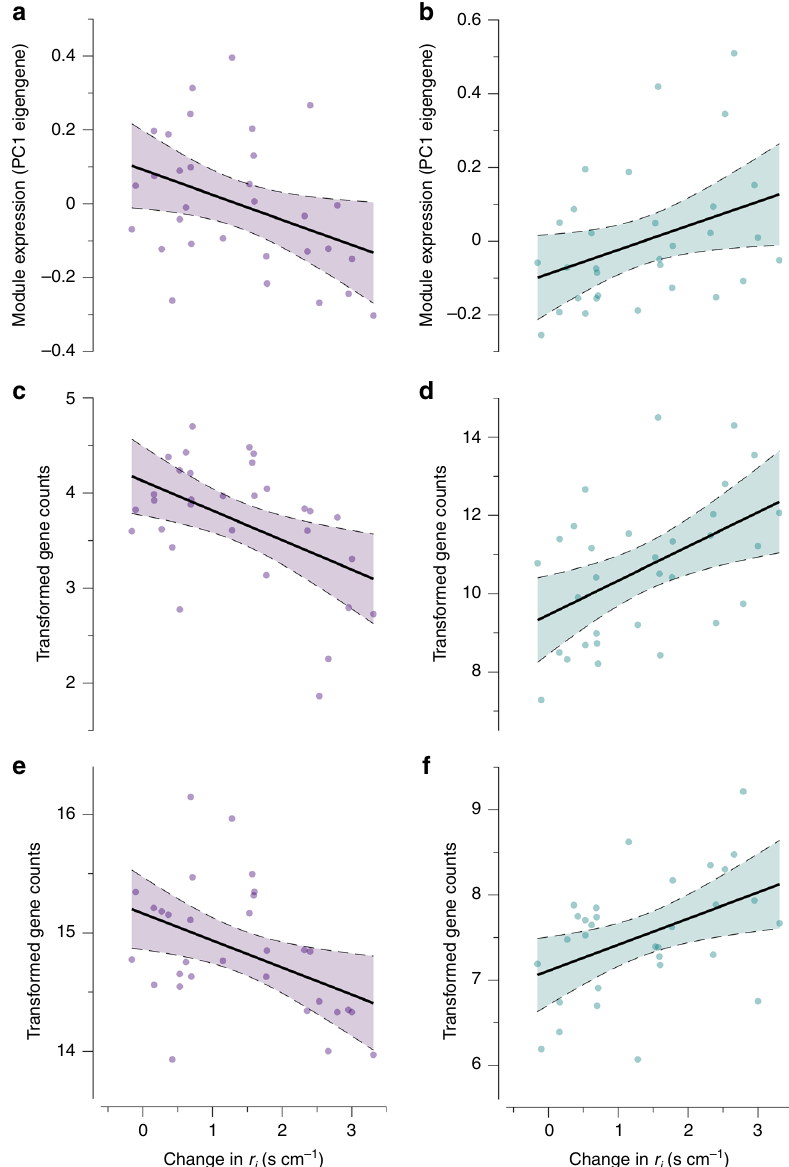
Fig. 4 Skin resistance modules and candidate genes associated with plasticity in r i . a The module negatively associated with r i . b The module positively associated with r i . These modules provided insight into the mechanisms underlying acclimation of r i by guiding subsequent analyses on gene ontology enrichment and hub gene identi fi cation. The fi gure also identi fi es four genes ( CHRM3 ( c ), TRIM63 ( d ), ALOXE3 ( e ), and PDE4B ( f )) within the skin resistance modules that correlated to plasticity in r i and were associated with GO terms related to water loss regulation. Temperature and humidity were not associated with the expression of these modules. Regressions are shown with 95% con fi dence